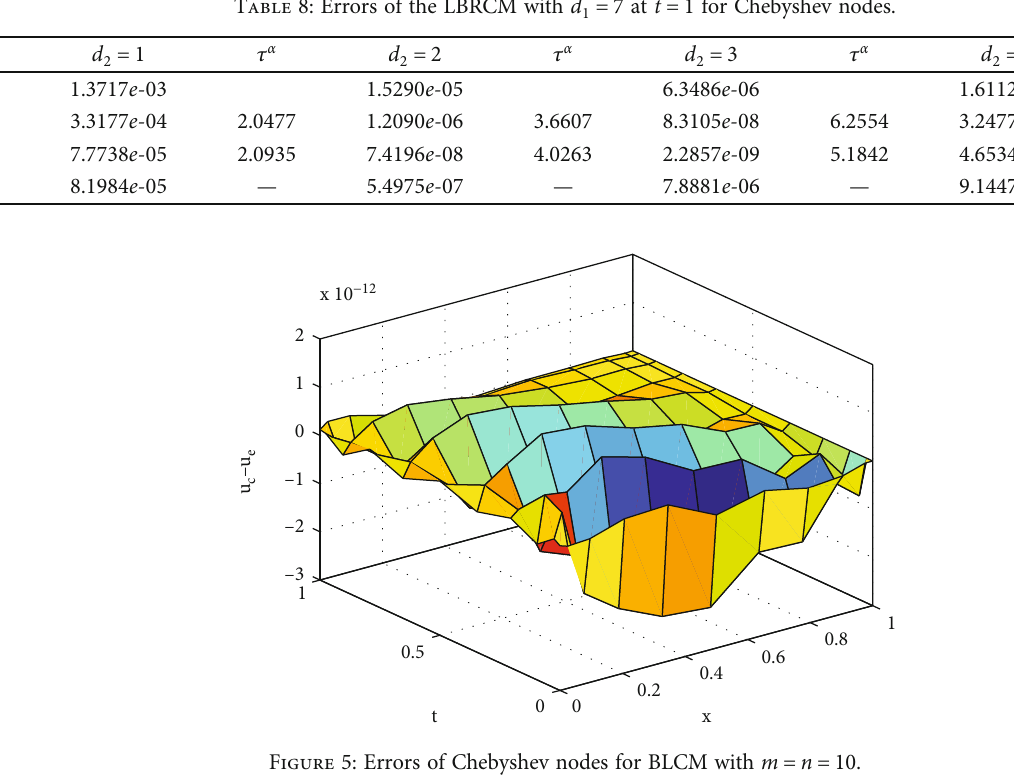
Table 7: Errors of the LBRCM with d